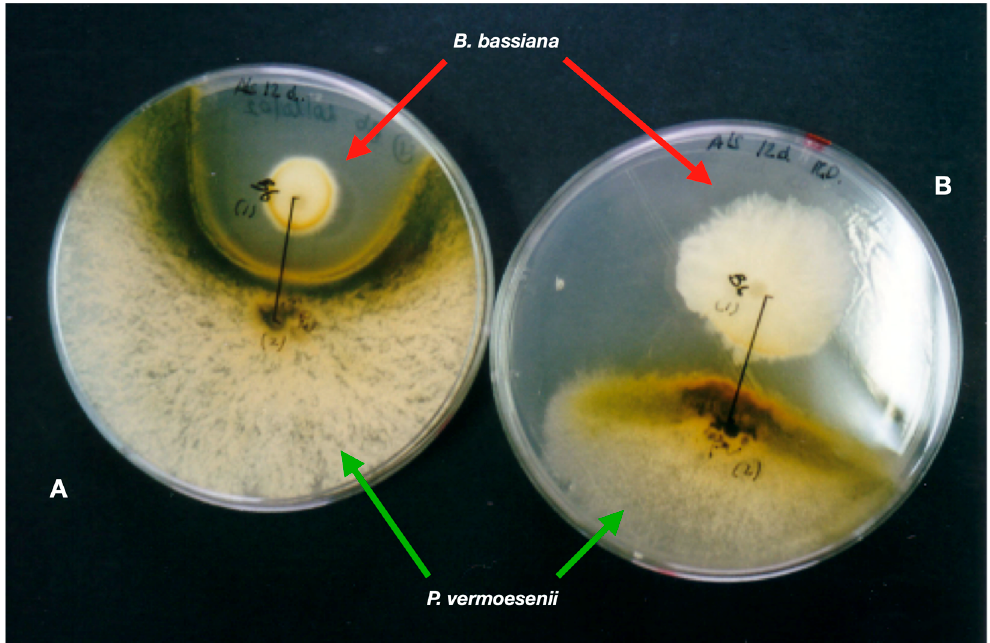
Figure 2. Beauveria bassiana (red arrows) inhibits the fungus palm pathogen Penicillium vermoesenii (green arrows). ( A ) Both fungi interact directly on the PDA medium. ( B ) The same two fungi on top of a dialysis membrane overlaid onto